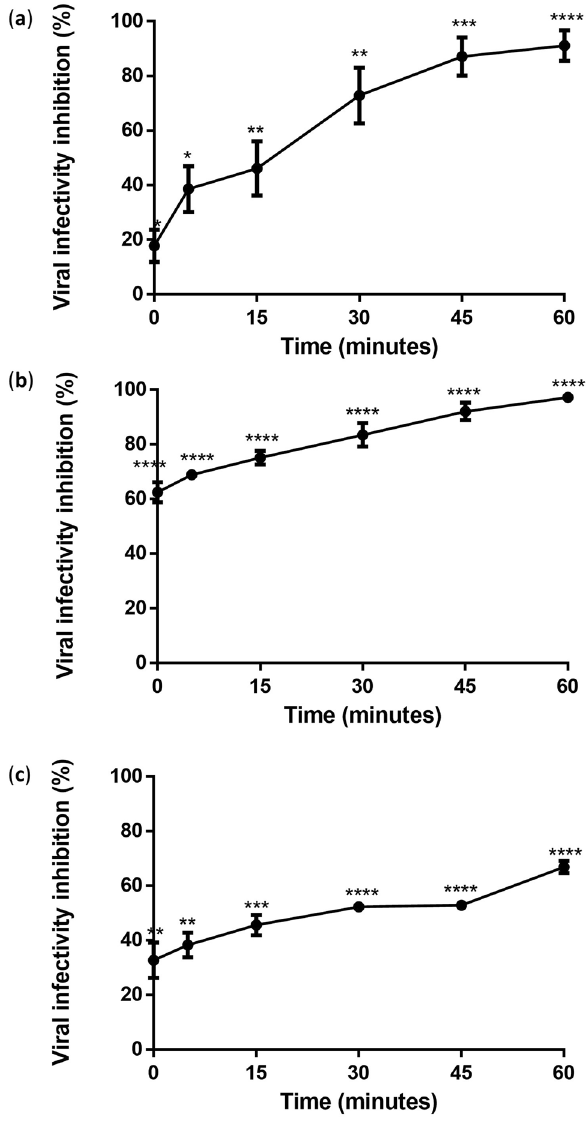
Figure 4. Extracellular virucidal activities of silymarin, baicalein, and baicalin against DENV-3 at different co-incubation times. ( a – c ) showed the inhibition of viral infectivity by silymarin (200 μg/mL), baicalein (100 μg/mL) and baicalin (20 μg/mL) after co-incubated with DENV-3 for 0, 5, 15, 30, 45 and 60 min at 37 °C. The flavonoid-treated DENV-3 from each time point was then used to infect Vero cells. Data presented as mean ± SEM. Error bars indicate the range of values obtained from three independent experiments. *P < 0.05, * *P < 0.01, * **P < 0.001, * ***P < 0.0001 indicates a significant difference compared to the negative control (0 μg/ mL) analysed by t